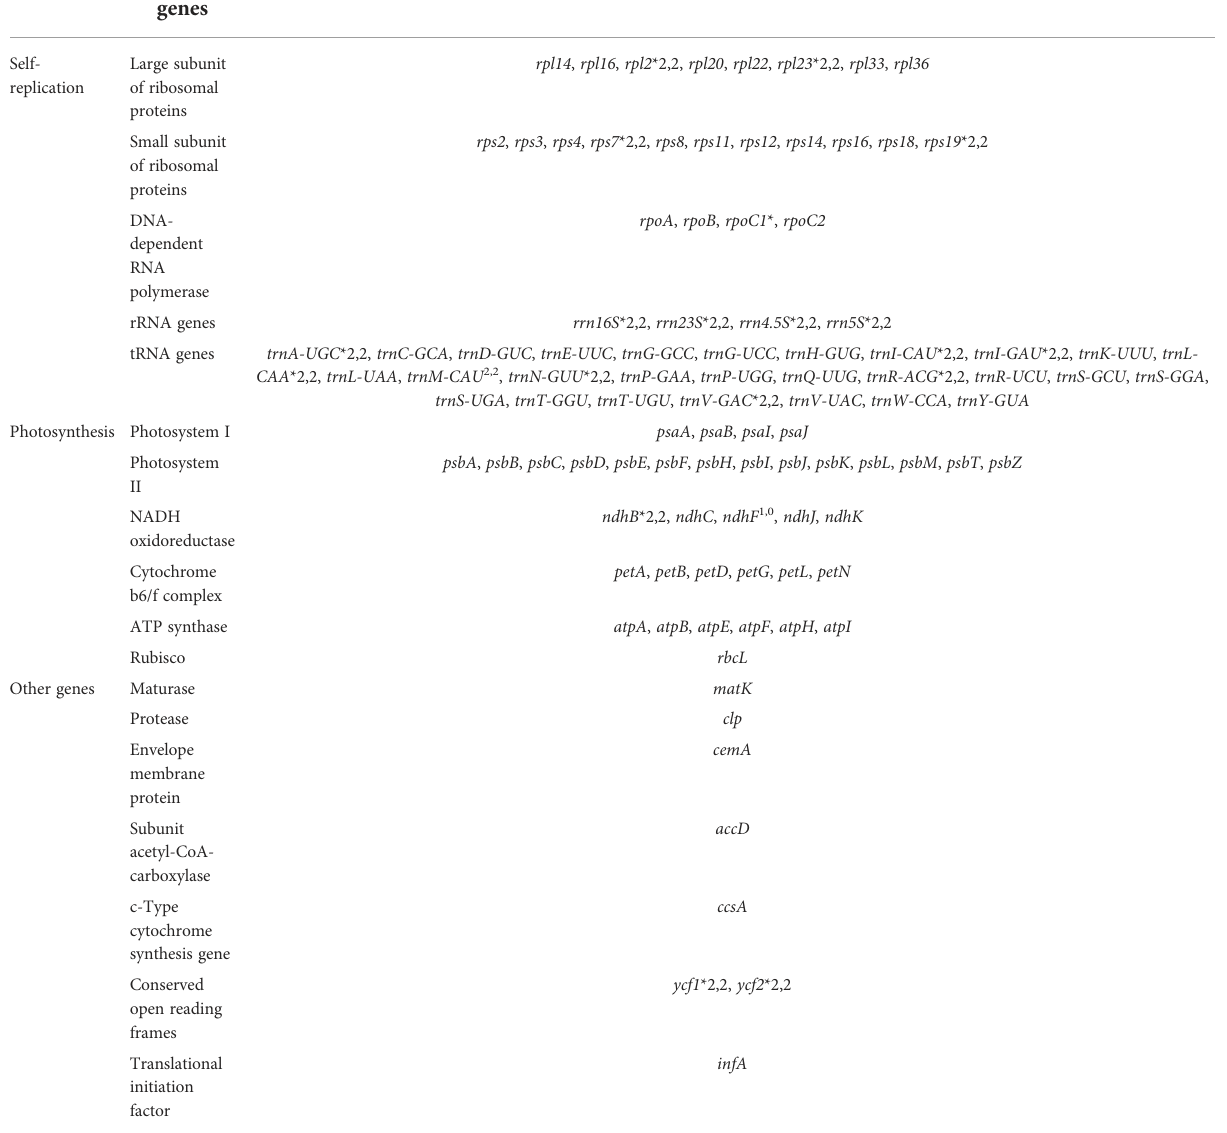
TABLE 2 List of genes annotated in the Phlomis fruticosa and Phlomoides strigosa chloroplast genomes. Category